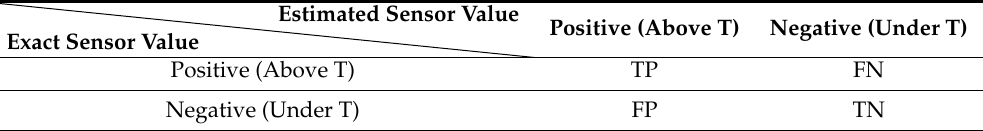
Table 2. False positive, false negative, true positive, and true